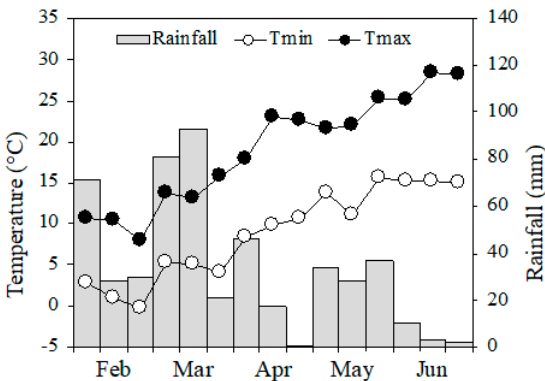
Figure 7. Air minimum and maximum temperatures and rainfall over the growing season 2018.